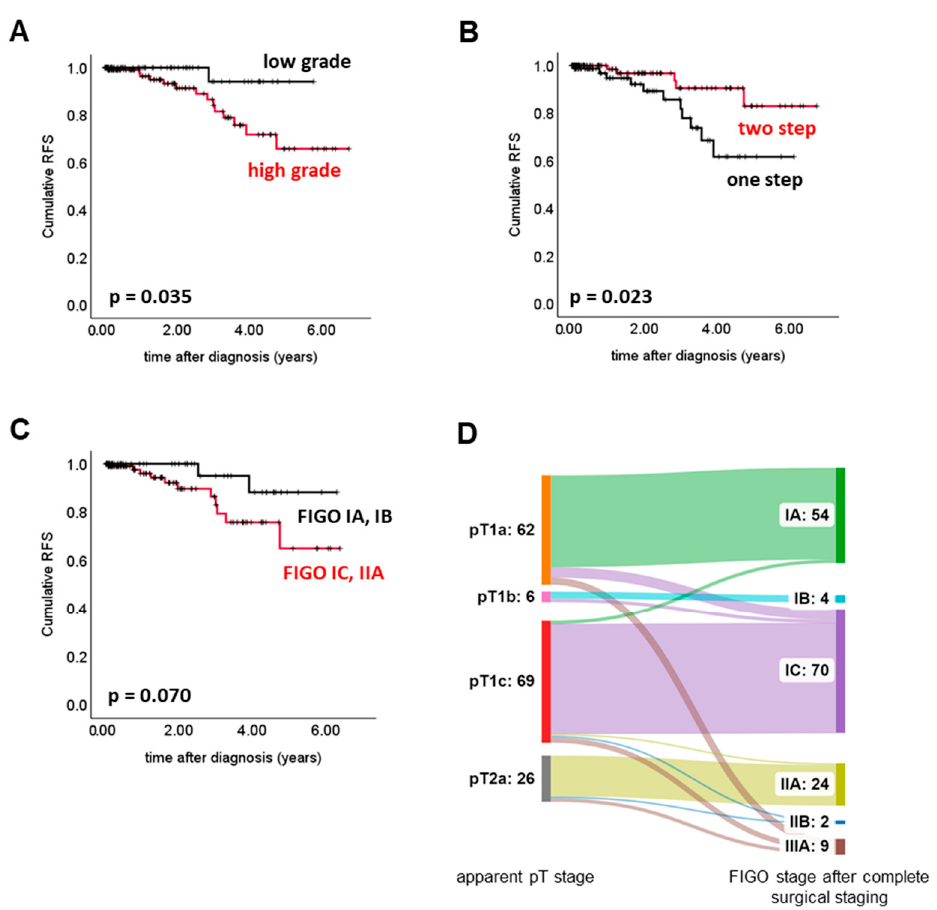
Figure 4. Completely Staged Patients. Survival analyses were performed in completely staged patients with initial pT1a-pT2a stage. High-grade histology (i.e., high-grade serous, clear cell (no grading), poorly differentiated (G3) endometroid, and poorly differentiated (G3) mucinous